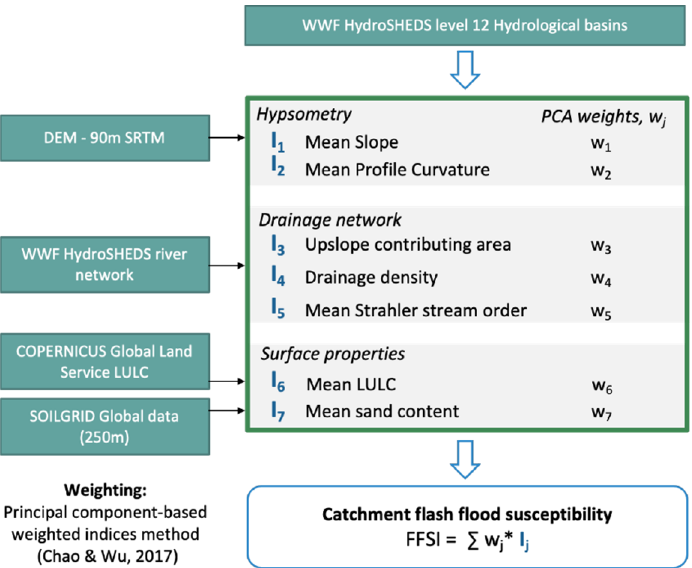
Figure 2. FFSI workflow for catchment scale, including remote sensing input data, geospatial indicators and resulting weights used in FFSI calculation.